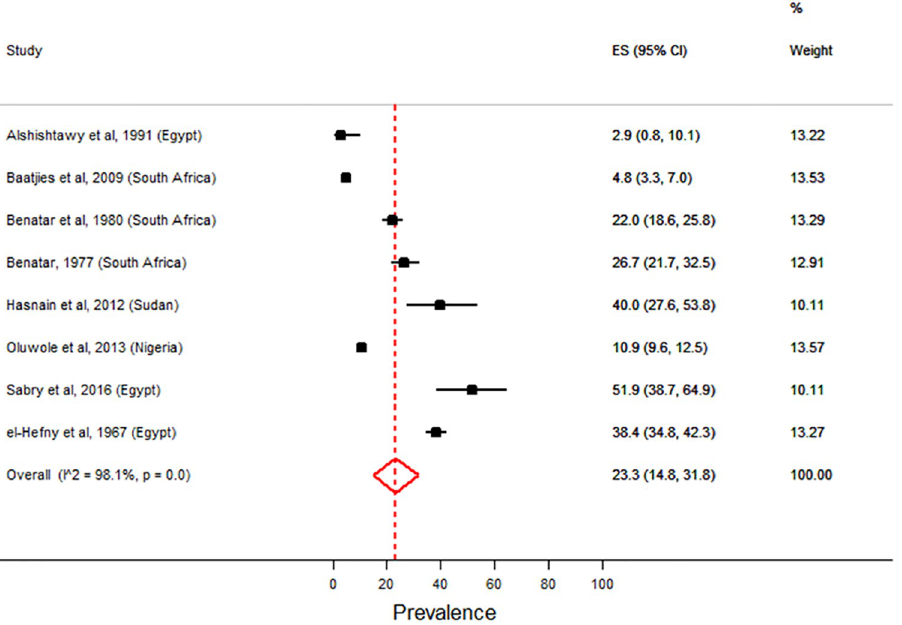
Fig 4. Forest plot showing meta-analysis on prevalence of fungal sensitisation. There was a lot of variation in the prevalence of fungal sensitisation across the eight studies included in the meta-analysis (p-value < 0.01). Broken vertical line indicates the combined (overall) estimates. ES (95% CI) denotes weighted estimates of prevalence and their 95% confidence intervals based on the variance in each individual study.